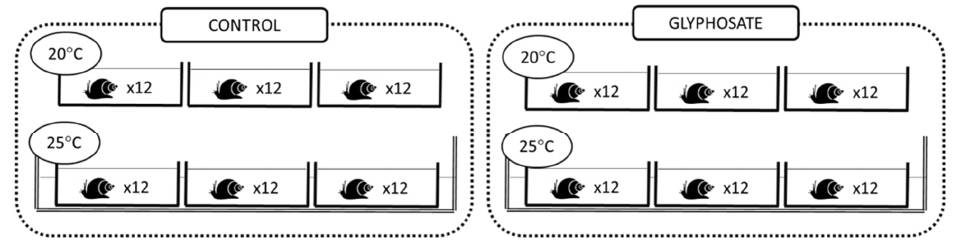
Figure 1. Experimental design with microcosms under control and contaminated conditions at two temperatures. Each microcosm contained 12